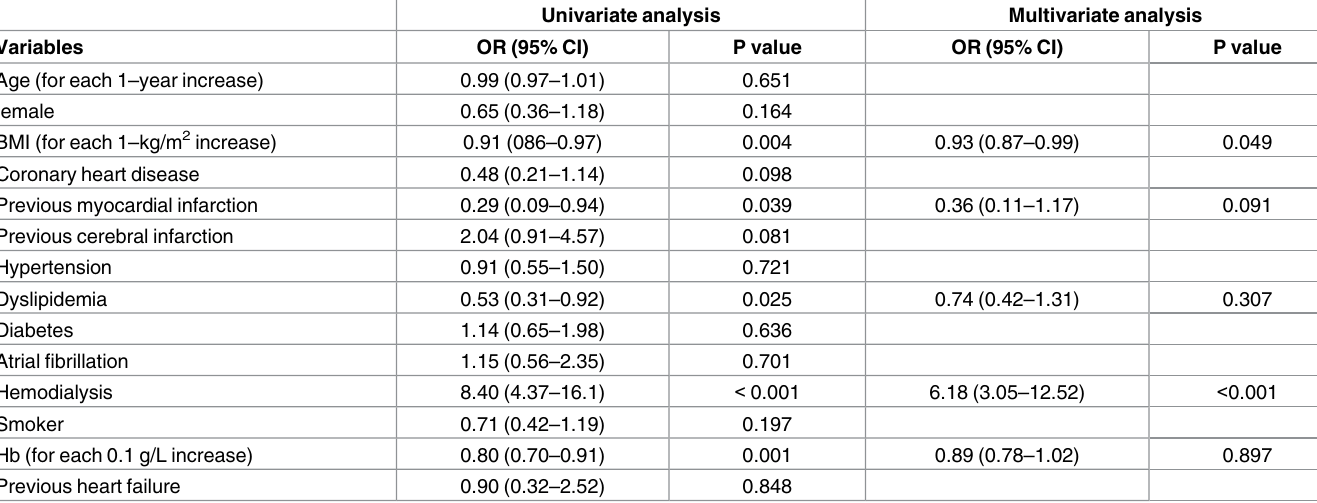
Table 2. Univariate and multivariate logistic regression analyses for high ankle brachial